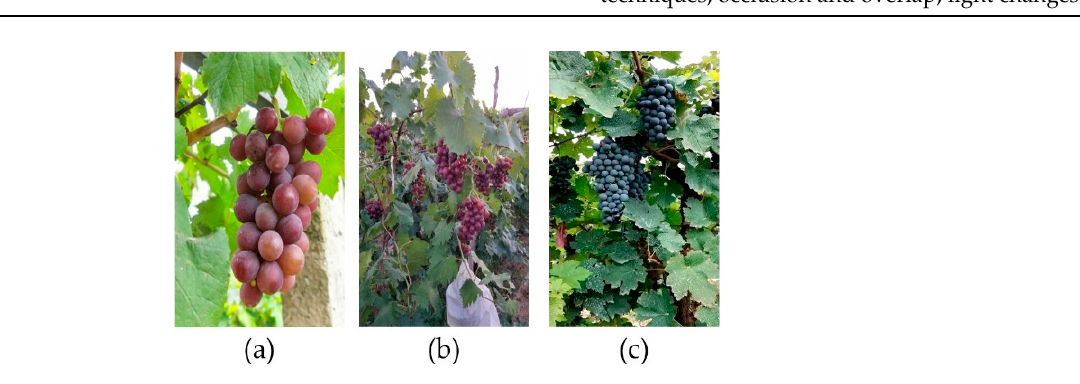
Figure 1. Color of Kyoho grapes in different growth periods: ( a ) Two grape clusters of different colors; ( b ) Different ripe grapes of different colors; ( c ) Different color from grapes in ( a , b ).